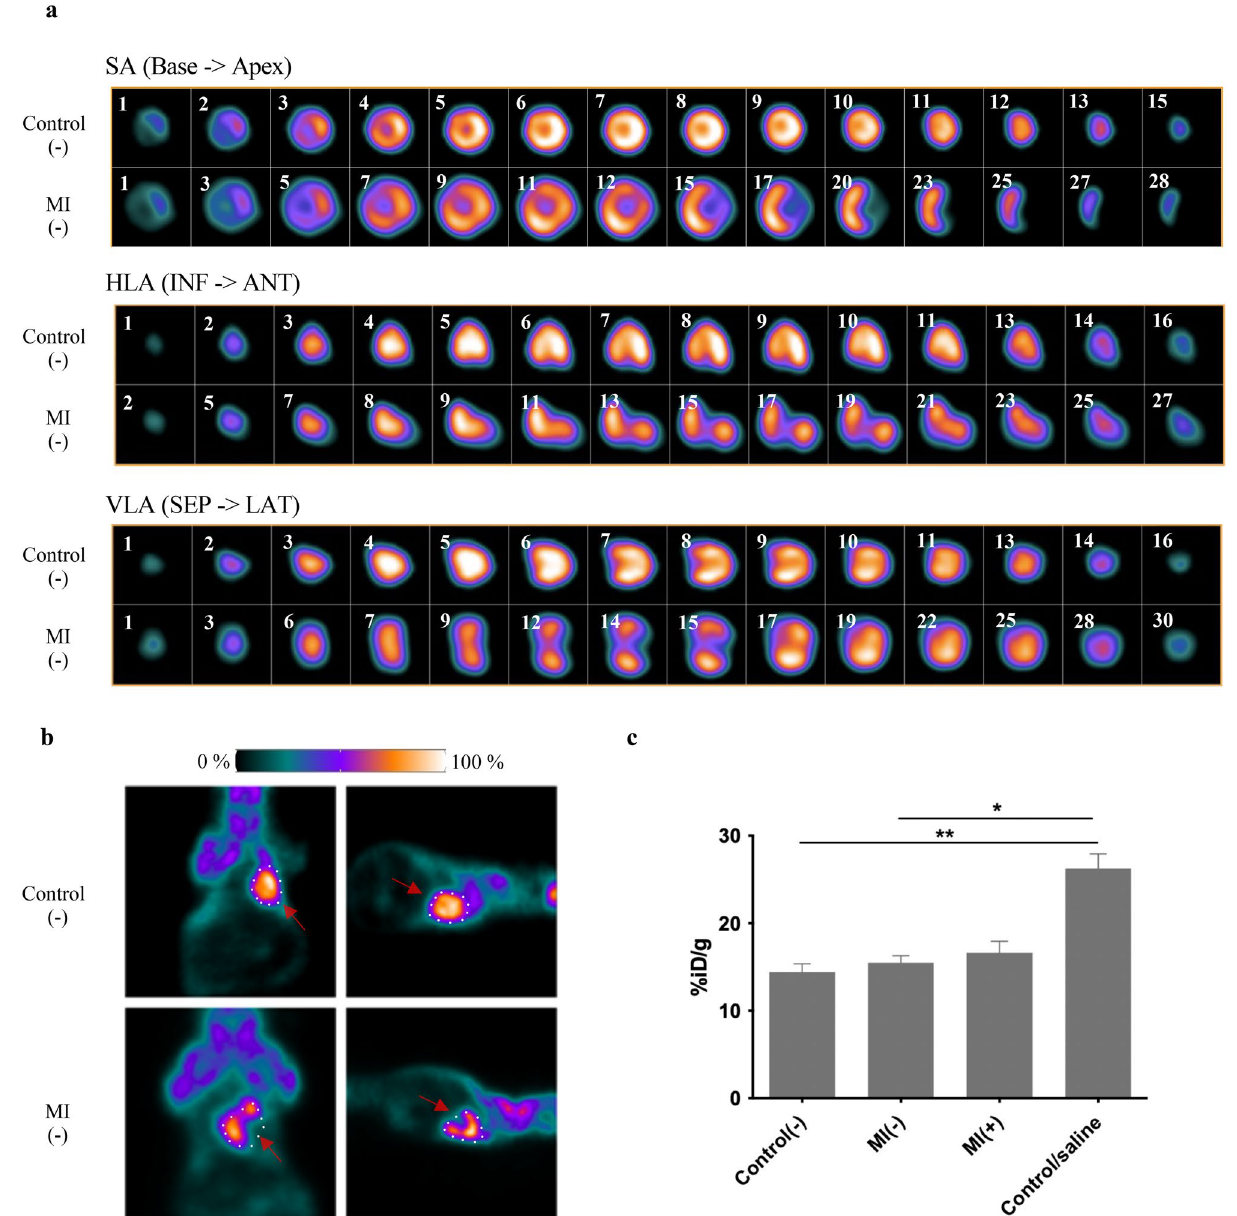
Figure 2. Functional and metabolic heart characteristics. ( a ) Images show a summary of cardiac viability measurements in control(−) (top row) and MI(−) (bottom row) mice administered the [ 18 F]-FDG tracer. Note the presence of MI in the apex area in axial, coronal, and sagittal planes (from top to bottom) and a larger size of the post-infarction heart due to its remodelling. ( b ) Representative PET images in the dorsal and lateral positions. Red arrows show loss of uptake in apex area ( c ) Comparison of cardiac [ 18 F]-FDG uptake in a group of control(−), MI(−) and MI(+) mice 7 days after cell implantation into the post-infarction heart and after saline injection. Statistical significance was evaluated with ANOVA and p-values are given as the mean ± SD; *p < 0.05, **p <